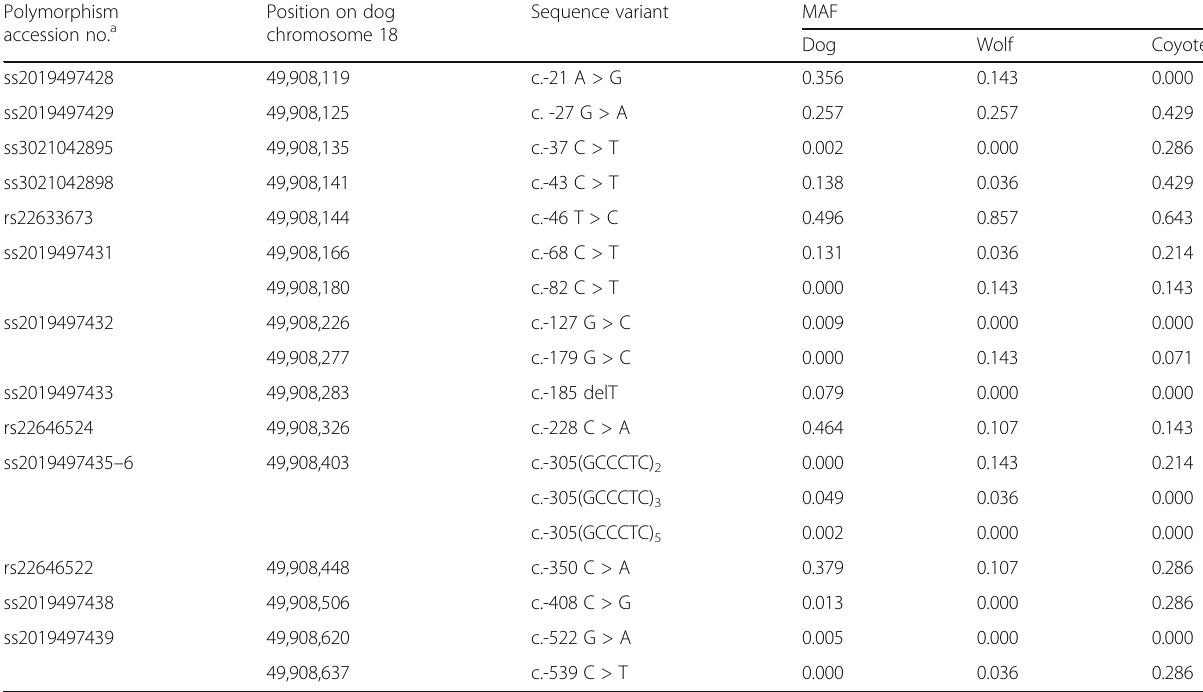
Table 1 GSTP1 promoter polymorphisms and minor allele frequencies (MAF) in domestic dogs, wolves and coyotes Polymorphism accession no. a